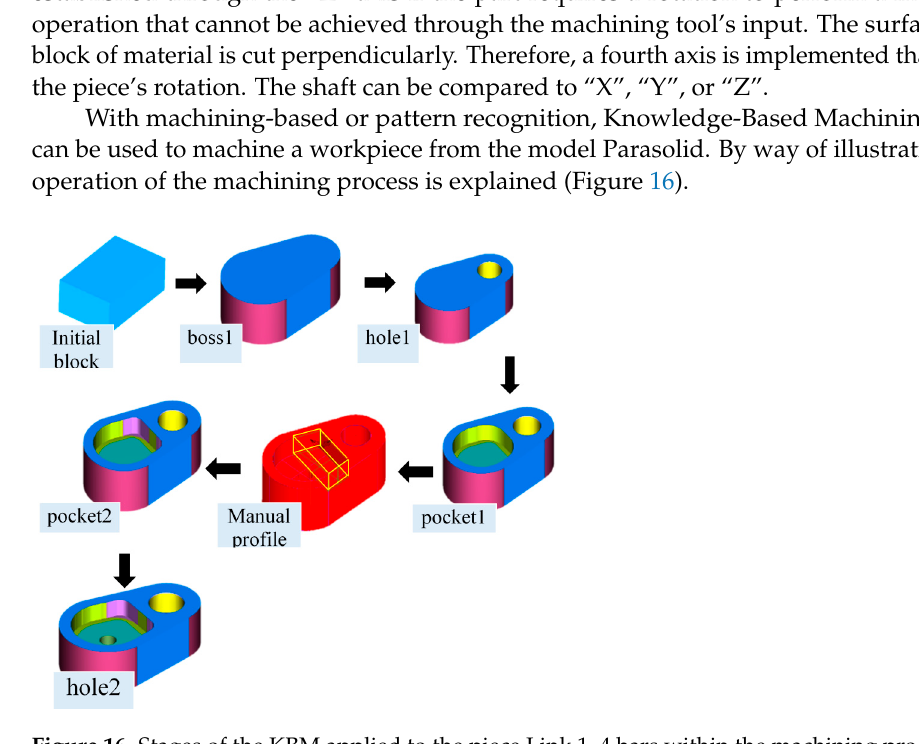
Figure 15. Link 1-4 bars of the mechanism of the upper limb prosthesis.